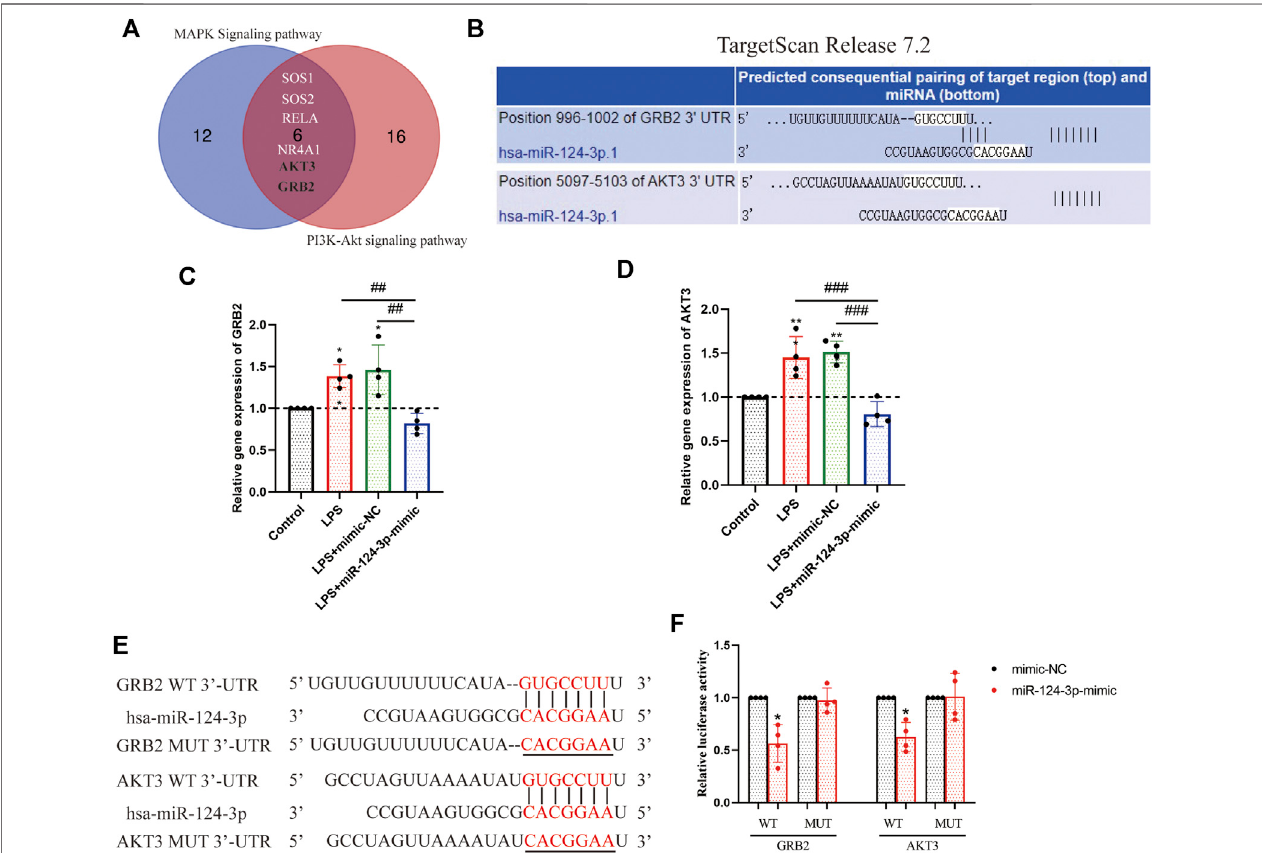
FIGURE7| Identi fi cationof GRB2 and AKT3 asadirecttargetof miR-124-3p inBV2microgliacells. (A) Venndiagramdisplayedtheoverlappingofthetargetgenes of miR-124-3p , involved in MAPK signaling pathway and PI3K/AKT signaling pathway, as predicted in 2.3 and 2.4 of methods. (B) Putative miR-124-3p binding sequencesinthe3 ′ -UTRof GRB2 and AKT3 mRNAwerepredictedusingtheTargetScandatabase. (C,D) Geneexpressionanalysisof GRB2 and AKT3 inBV2microglia afterLPS-inducedor/andtransfectedwith miR-124-3p -mimic. (E) The miR-124-3p bindingsiteinthe3 ′ UTRof GRB2 and AKT3 andthe3 ′ UTRmutantsequences. (F) Quali fi cation of luciferase activity for targeting the correlation between miR-124-3p and GRB2/AKT3. All values represent mean ± SD. * compared to control, * p < 0.05; ** p < 0.01; # Difference between groups, ## p < 0.01; ### p < 0.001; one-way ANOVA with the Newman – Keuls multiple comparison test; n (cid:2) 4.